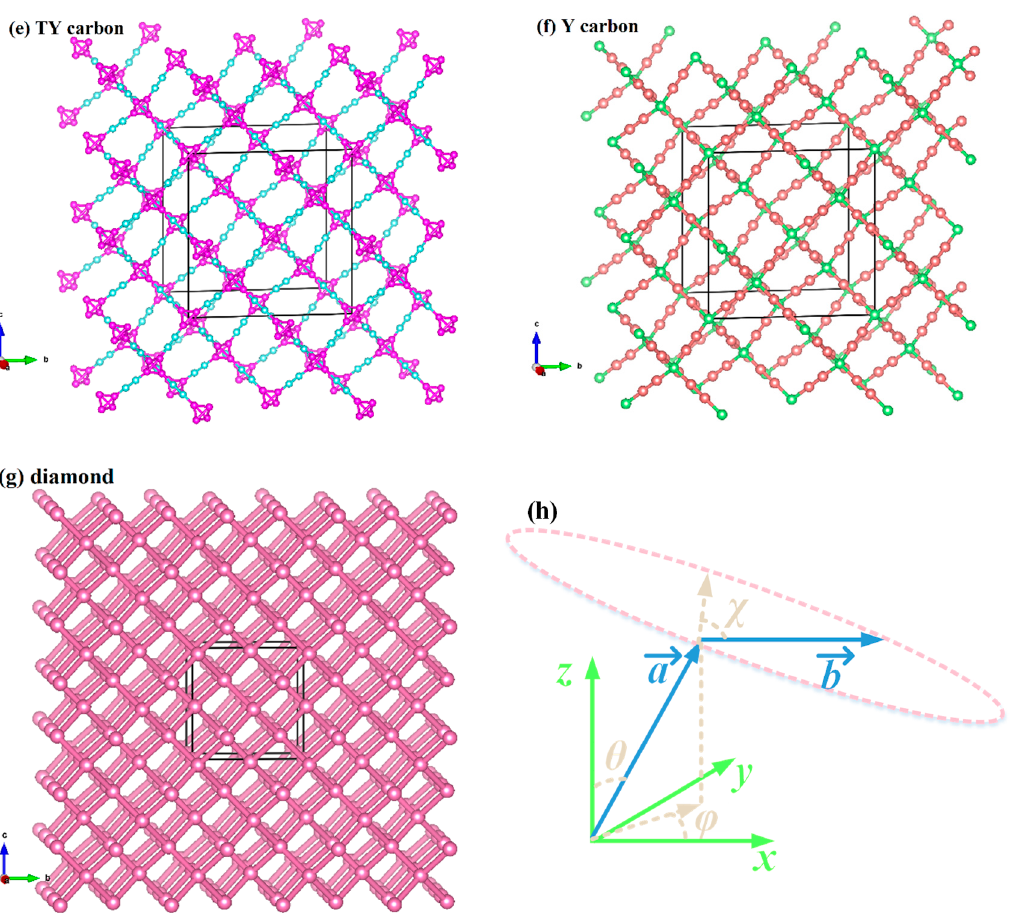
Figure 1. The crystal structure of cubane-diyne ( a ), cubane-diyne ( b ), supercubane ( c ), T carbon ( d ), TY carbon ( e ), Y carbon ( f ), and diamond ( g ). Definitions of angles used to describe directions in mechanical anisotropy calculations ( h ).